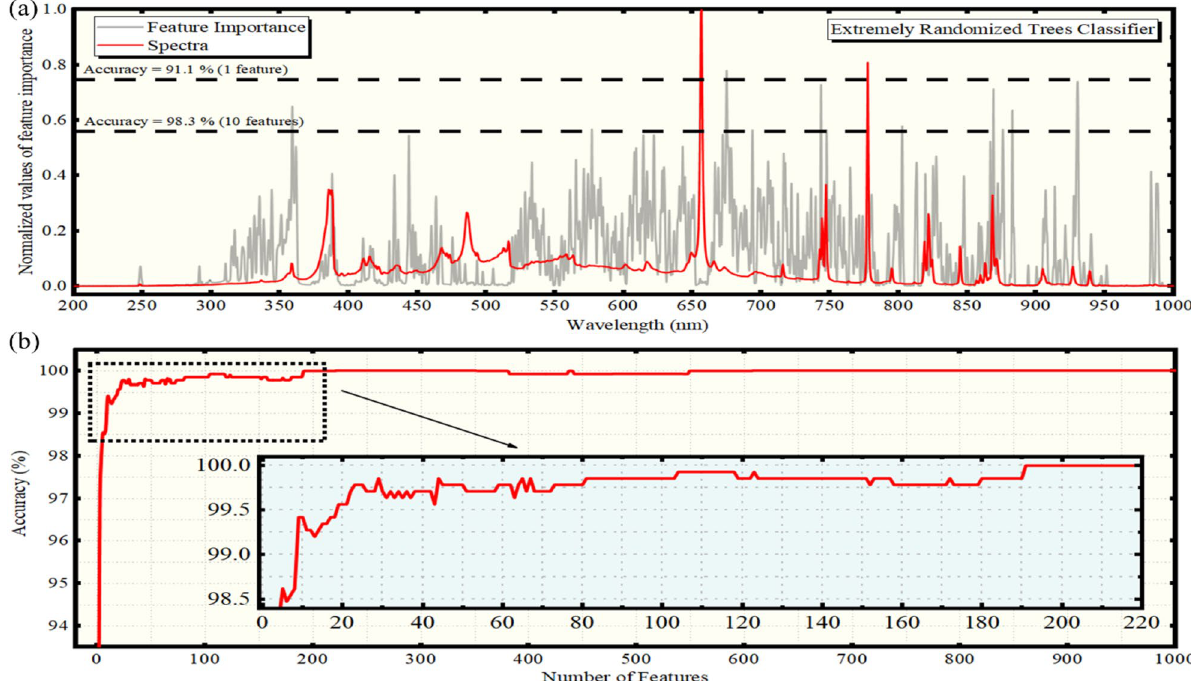
Figure 2. ( a ) Feature importances (gray line) versus wavelength resulting from the ERTC algorithm. An experimental LIBS spectrum (red line) is shown for comparison. The horizontal dashed lines indicate the number of features threshold and the corresponding computed accuracies. ( b ) Prediction accuracy using the ERTC algorithm versus the number of features.